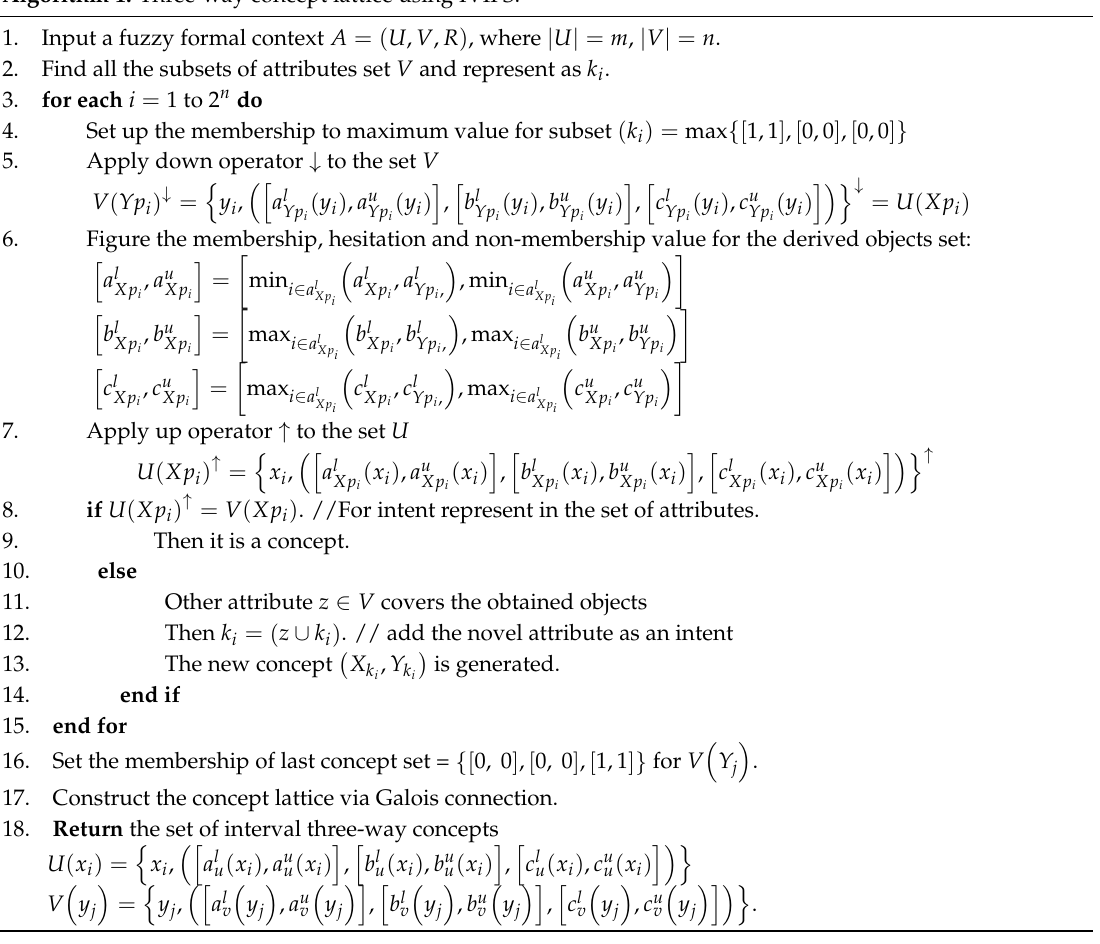
The Algorithm 1 generates interval-values intuitionistic fuzzy concepts via subset of